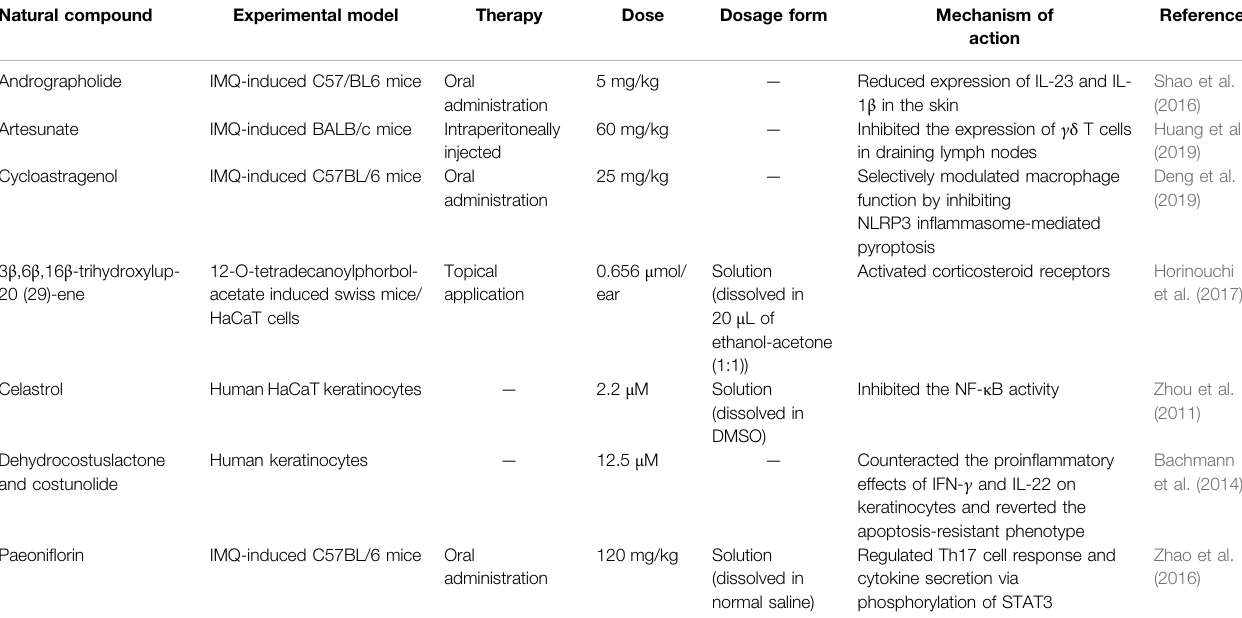
TABLE 3 | Terpenoids for the treatment of psoriasis.